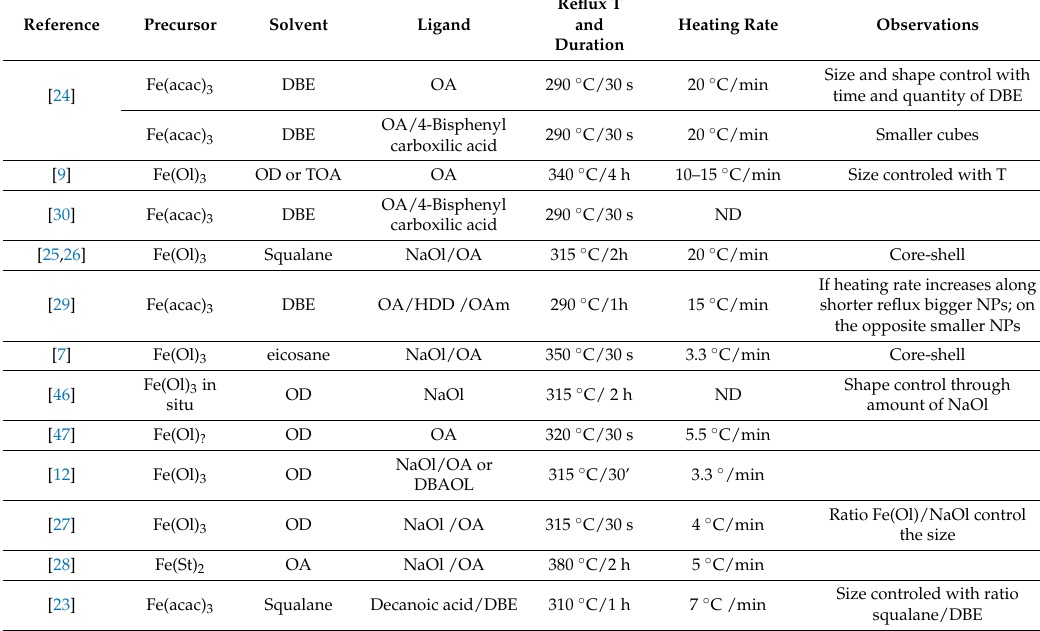
Table 1. Some reported nanocubes syntheses from